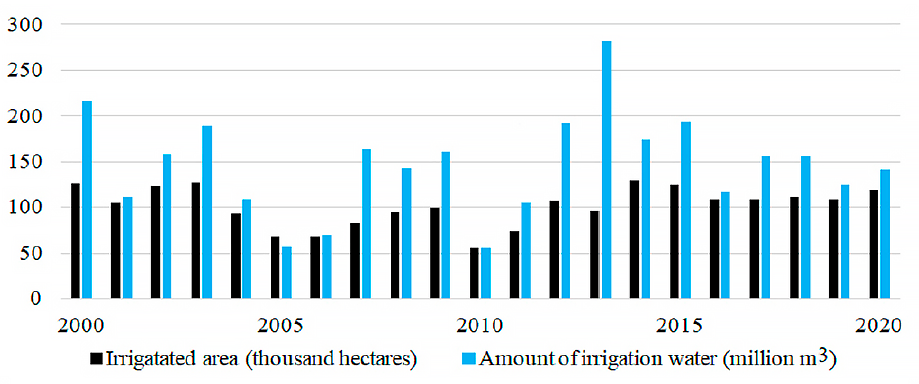
Figure 7. The extent of irrigated areas and the volume of irrigated water in Hungary between 2000 and 2020 (based on the Hungarian Central Statistical Office)